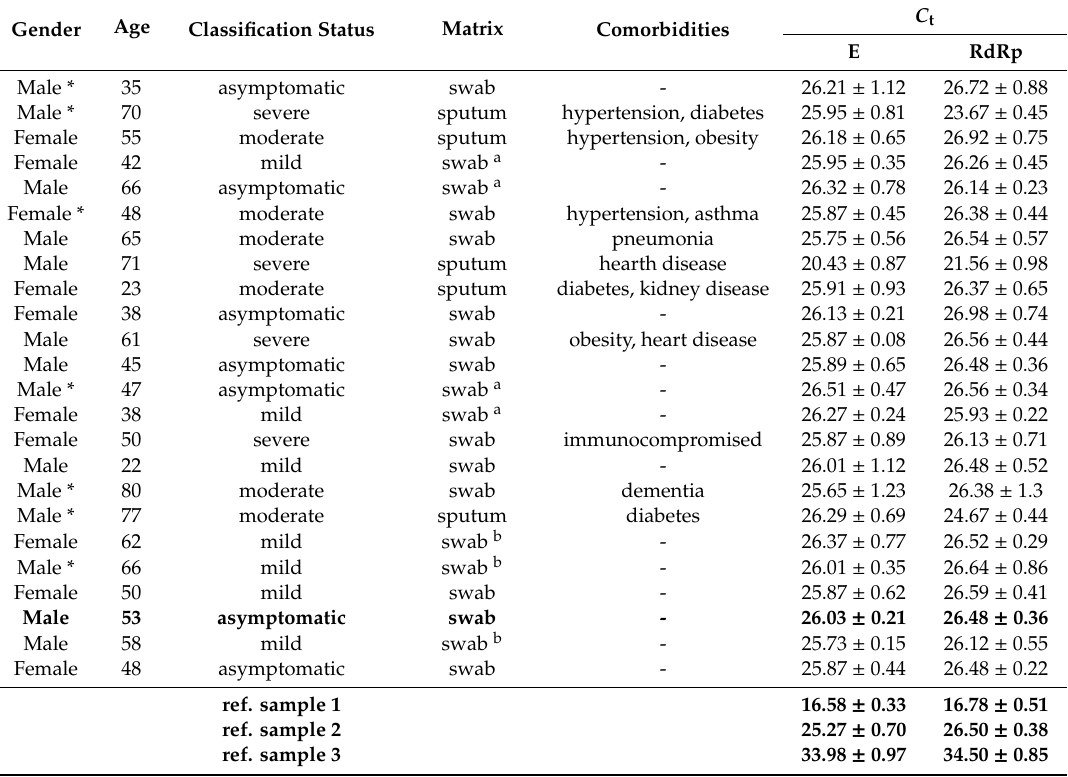
Table 2. Di ff erent sample matrixes collected from COVID-19-confirmed patients.